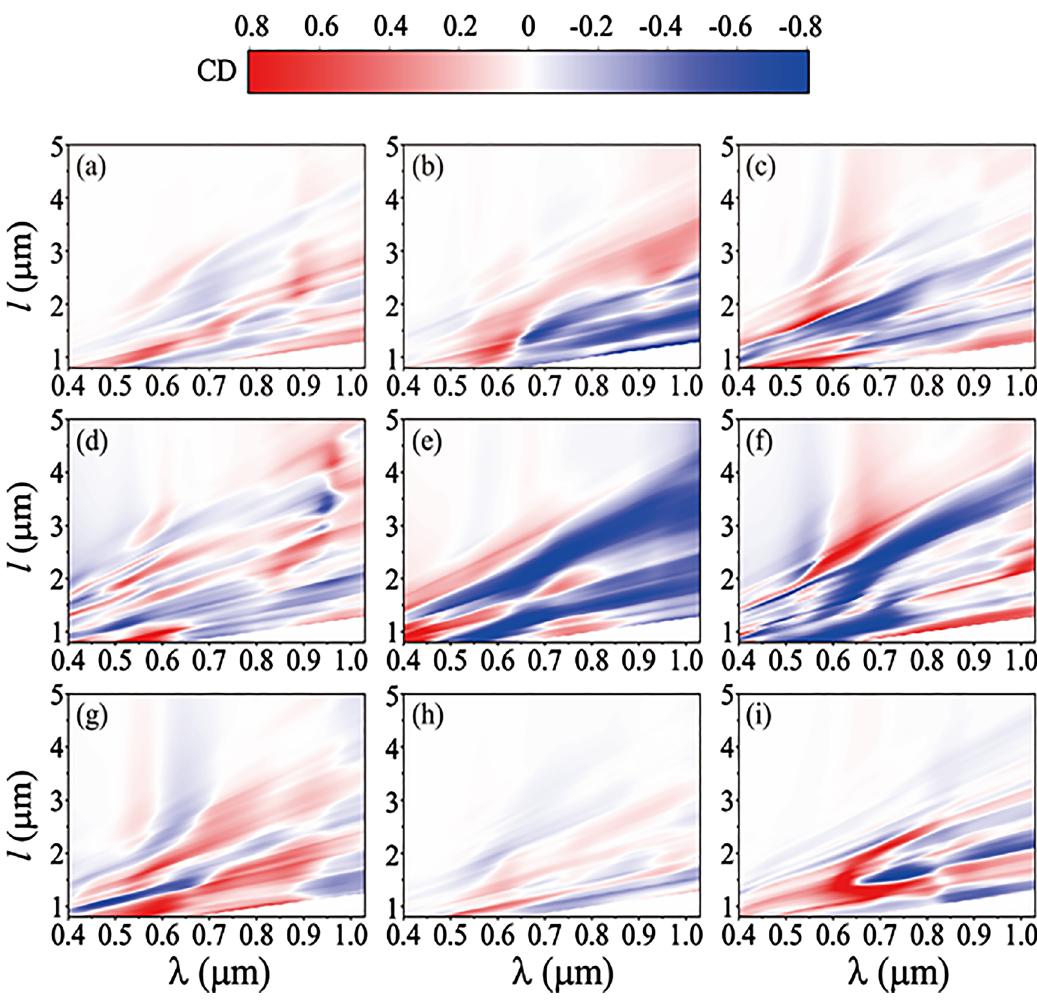
Figure 7: Contour maps of the third-order diffracted circular dichroism (CD) response in S1 – S9 chiral metamaterials, accounting for different wavelength and gold length. All the presented results are computed using the model-agnostic data enhancement (MADE)